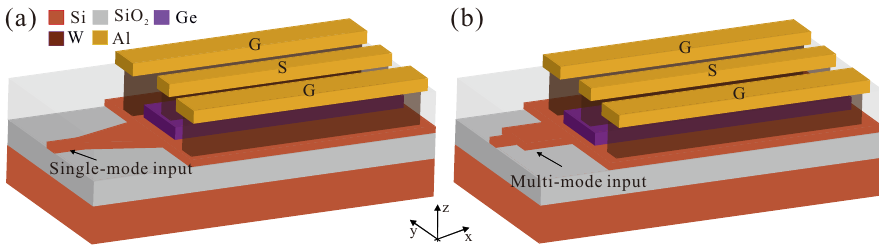
Figure 1. Schematic: ( a ) Typical photodetector (T-PD) with a single-mode waveguide input. ( b ) Multi- mode input photodetector (MM-PD), and the single-mode waveguide is the excitation